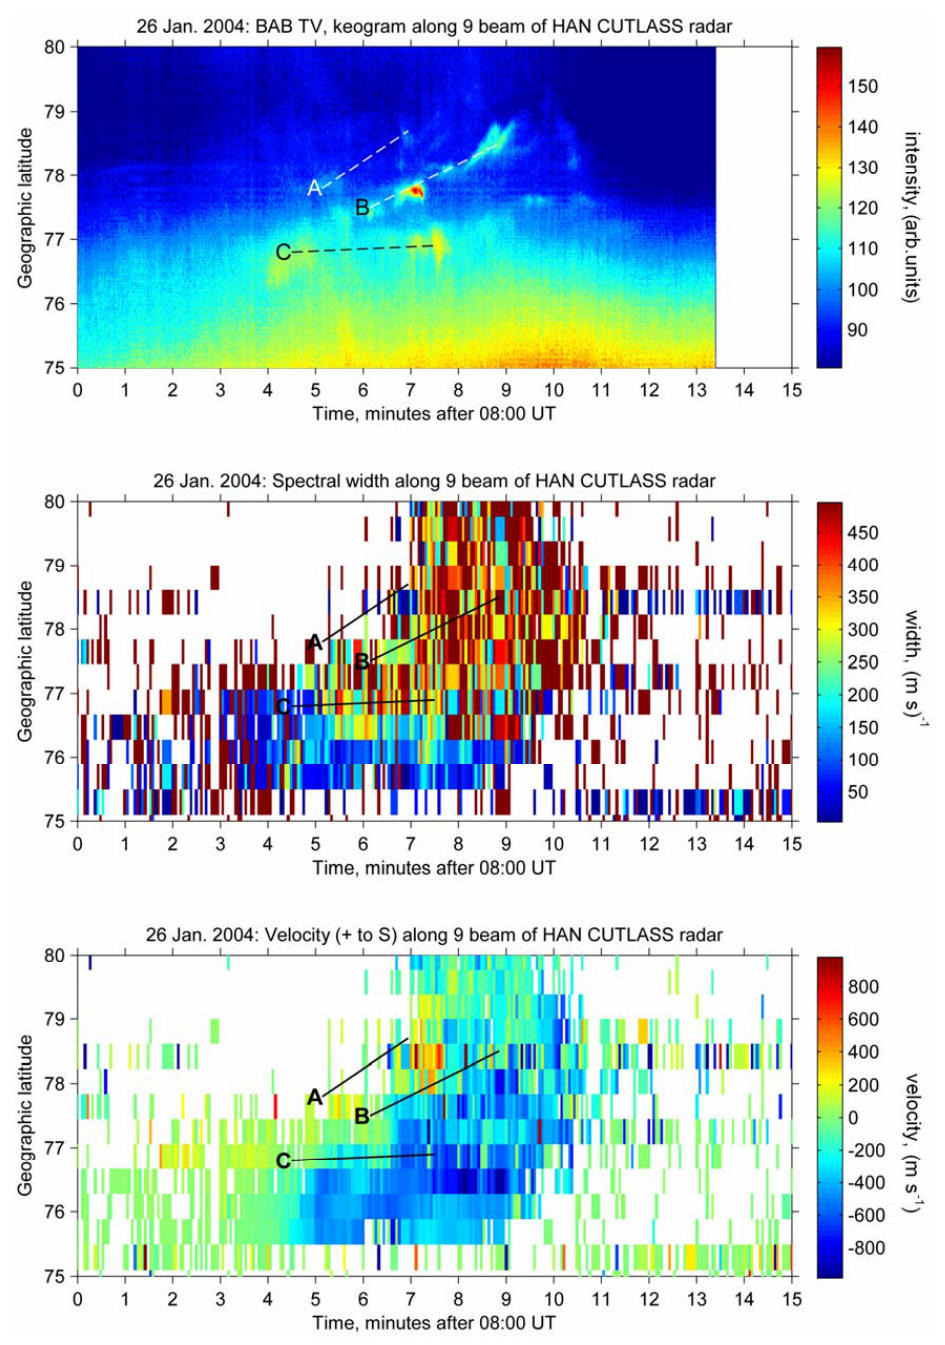
Fig. 7. Location of the ionospheric irregularities with respect to the auroral arcs A, B and C. The velocity scale here is reversed with respect to that in Fig. 5.